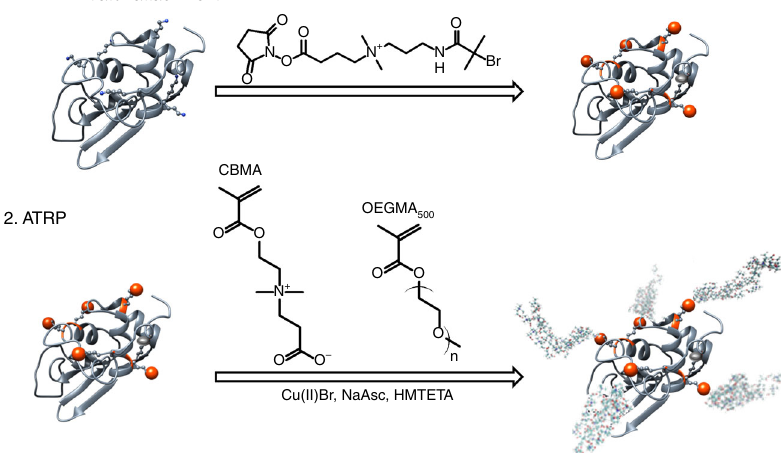
Fig. 1 Grafting-from Lyz – polymer conjugate synthesis using ATRP. A positively charged ATRP initiator was fi rst reacted with accessible amino groups on Lyz ’ s surface. Next, ATRP was used to grow polymers of zwitterionic CBMA or neutral OEGMA at increasing polymer lengths. Additional acronyms: sodium ascorbate (NaAsc), 1,1,4,7,10,10-Hexamethyltriethylenetetramine (HMTETA)